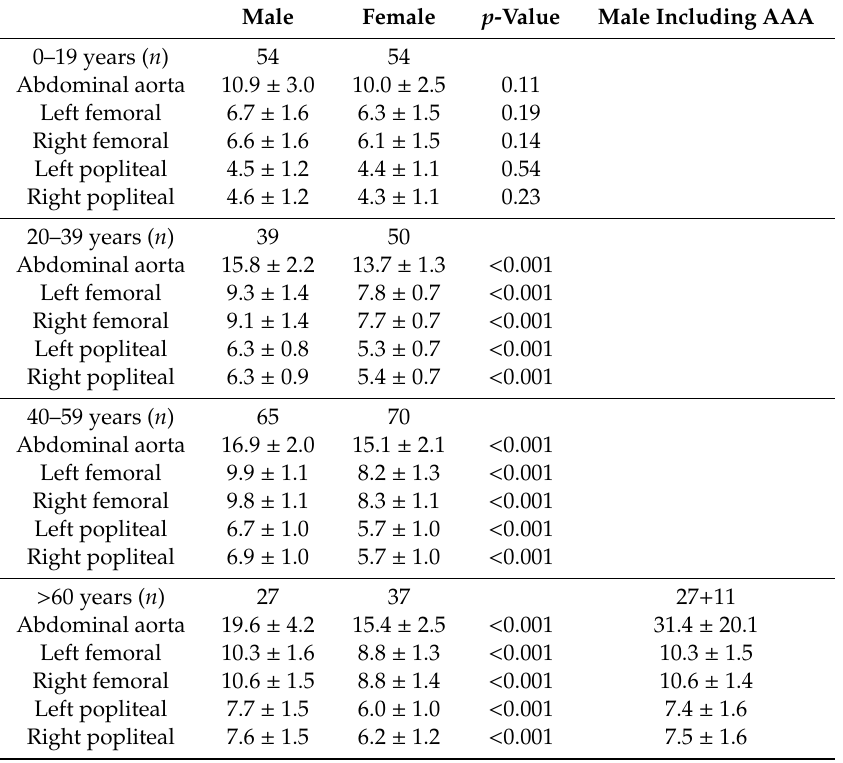
Table 2. Arterial diameters in males and females per every 20-year